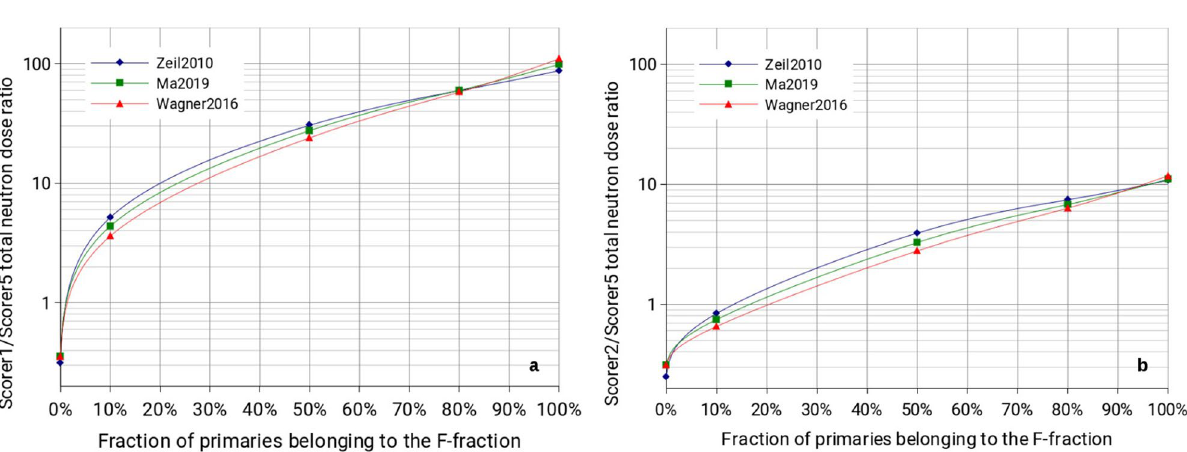
Figure 12. ( a ) Ratio between the neutron dose calculated in scorer 1 and scorer 5 depending on the fraction of primaries belonging to the F-fraction. ( b ) Ratio between the neutron dose calculated in scorer 2 and scorer 5 depending on the fraction of primaries belonging to the F-fraction. To guide the eye, a spline interpolation has been